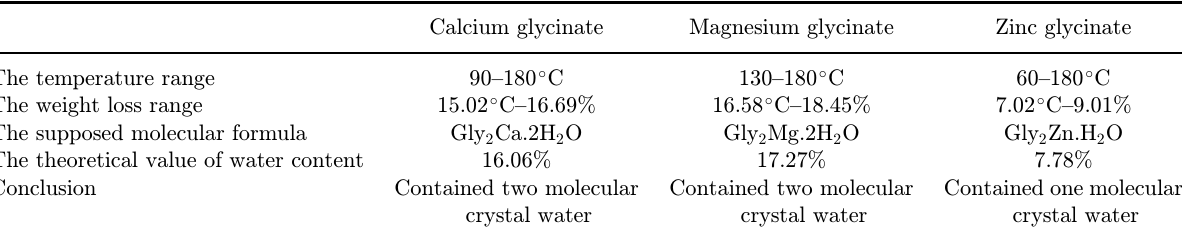
Table 1. Results of thermal